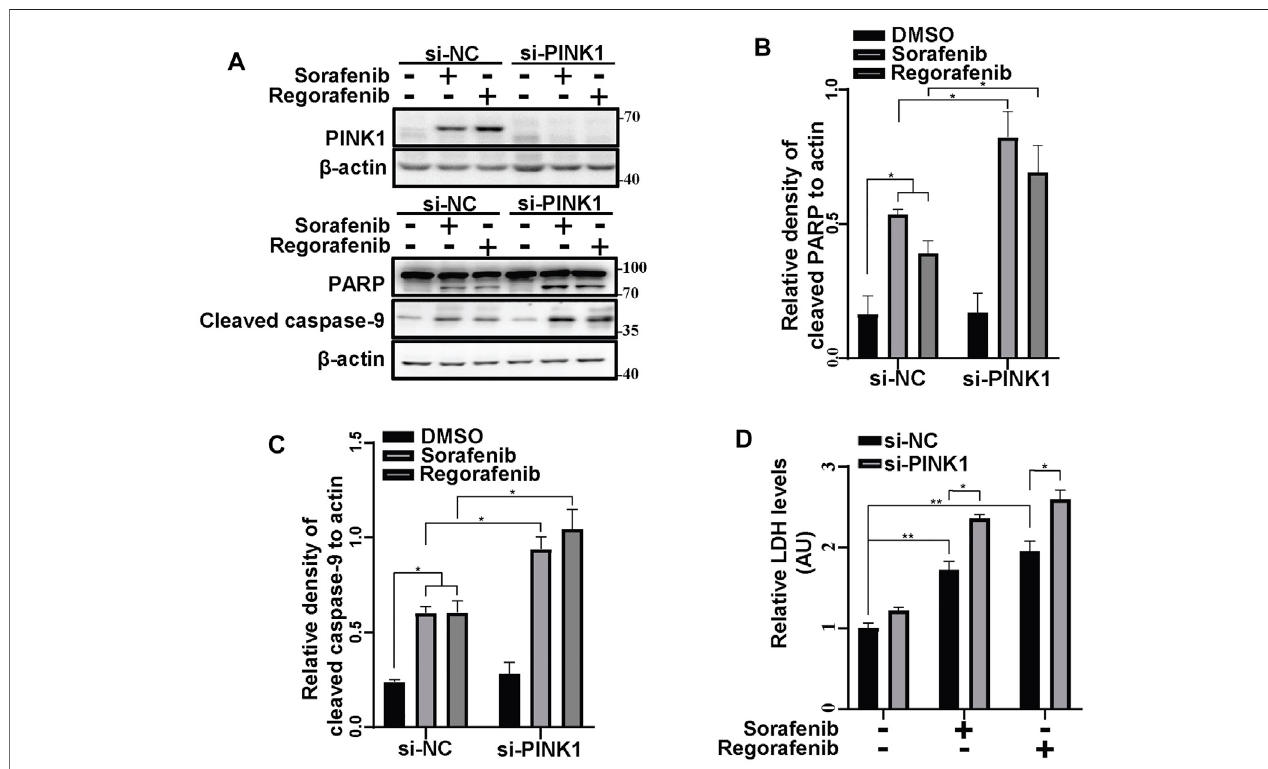
FIGURE 7 | Inhibiting mitophagy by knockdown of PINK1 enhances the sorafenib- and regorafenib-induced cleavages of PARP and cleaved caspase-9. (A) PINK1, cleaved PARP and cleaved caspase-9 in HepG2 cells that were transiently transfected with siRNA to PINK1 for 48 and then treated with sorafenib (20 μ M) or regorafenib(30 μ M)for24 hwerelabeledwiththeindicatedantibodies. (B,C) TherelativedensitiesofcleavedPARP (B) andcleavedcaspase-9 (C) werequanti fi ed,with the protein level normalized to the loading control ( β -actin). Values are the mean ± SEM from three independent experiments (* p < 0.05, two-way ANOVA and Tukey ’ s multiple comparisons test). (D) Cytotoxicity was measured using LDH assays in HepG2 cells that were treated as in (A) . Values are the mean ± SEM from three independent experiments (* p < 0.05, ** p < 0.01, two-way ANOVA and Tukey ’ s multiple comparisons